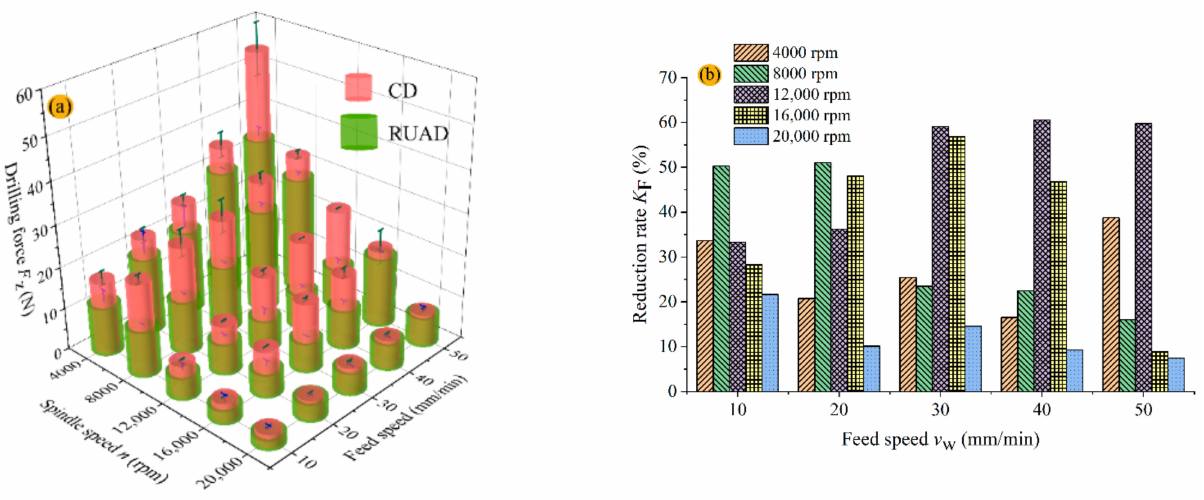
Figure 8. Influence of spindle speeds and feed rates on drilling force, ( a ) variation trend of drilling force, ( b ) reduction rate K F of drilling